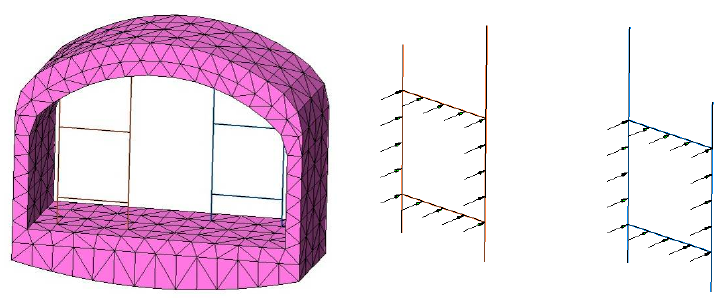
Figure 3. Fixed brackets and longitude thrust in a heat-supplying tunnel.